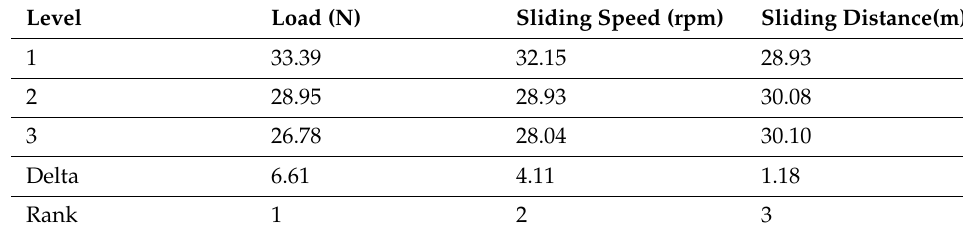
Table 10. Response Table for Signal to Noise Ratios (Smaller is better).